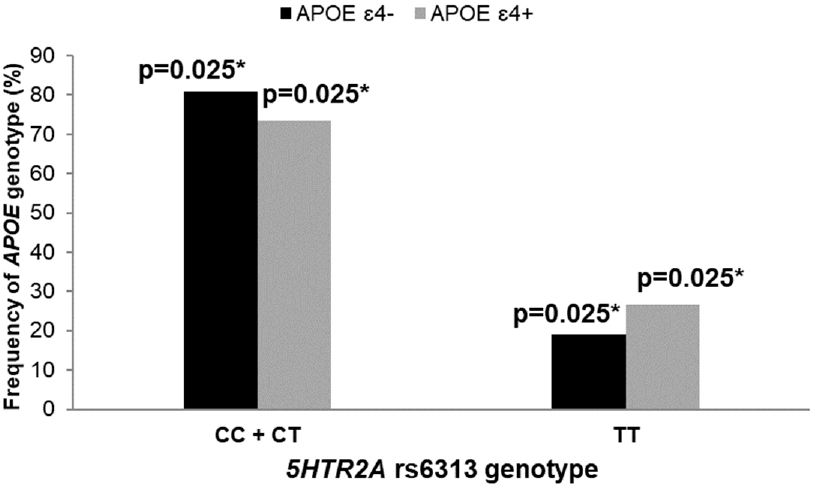
Figure 2. Frequency of APOE genotype in females younger than 65 years of age with different 5HTR2A rs6313 genotypes. * p < 0.05. A significantly higher number of APOE ε 4 allele carriers was also observed among male patients carrying the CC and CT genotypes compared to carriers of the TT genotype within the 5HTR1B rs13212041 polymorphism ( χ 2 = 7.064, df = 1; p = 0.008; Figure 3). Additionally, a significantly higher number of individuals carrying the C allele within the 5HTR1B rs13212041 polymorphism was observed among AD patients ( χ 2 = 6.973, df = 1; p = 0.008; Figure